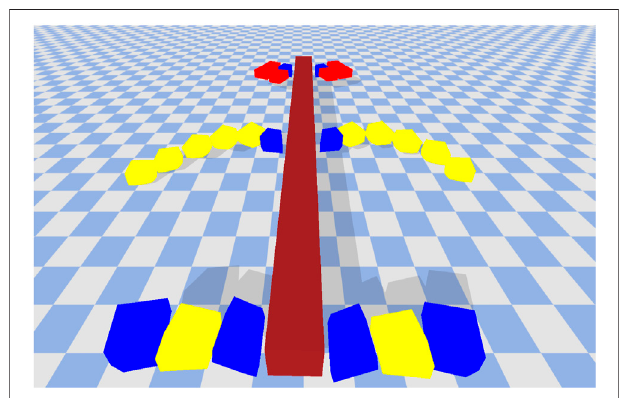
FIGURE 10 | An example of a solution which transfers well to a different environment. This solution had a fi tness of 42.14 on the high friction surface and when transferred to the low friction surface it was able maintain a reasonable fi tness value of 36.14. Normalized Friction (cid:2) 0.71,